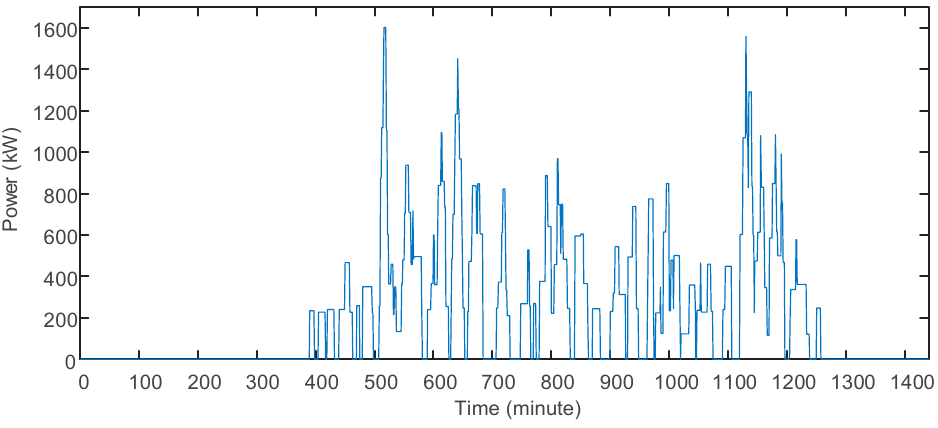
Figure 2. Total charging load of the station.